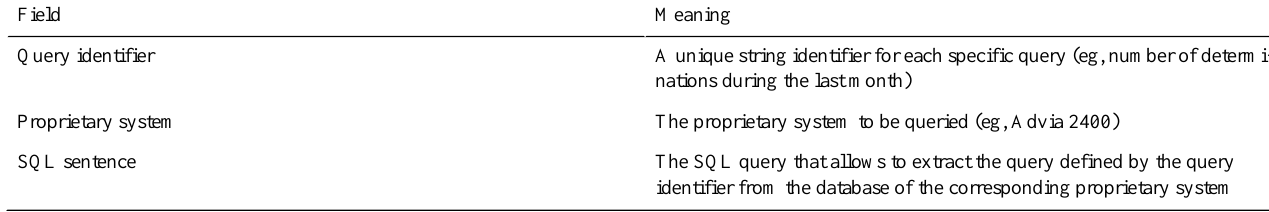
Table 1. Fields in the data table.